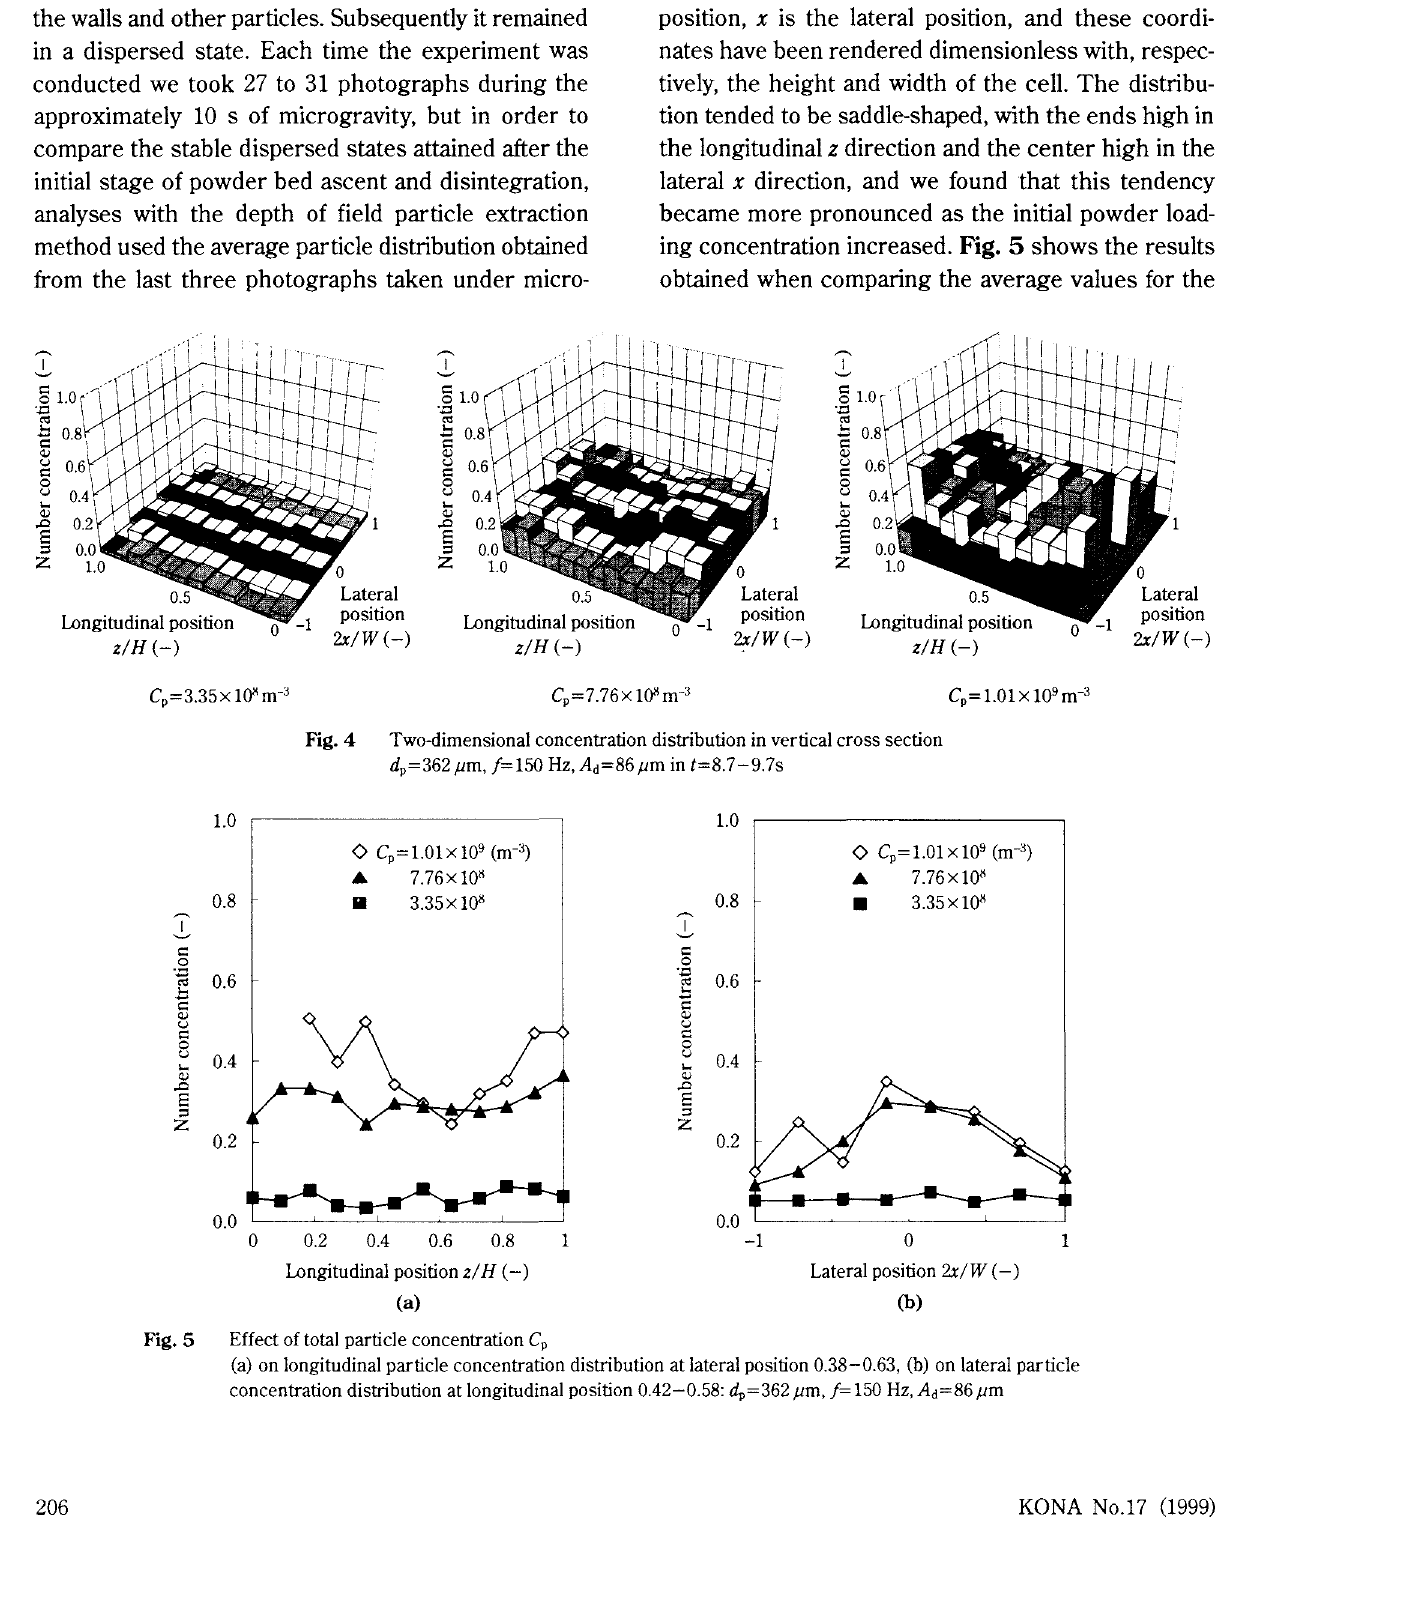
0 Cp= 1.01 x 10 9 (m- 3) ...